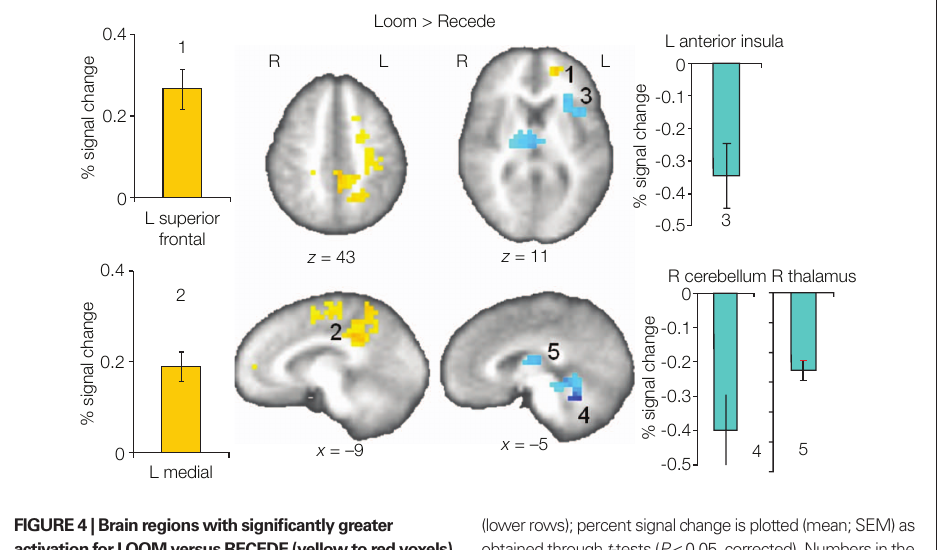
FIguRe 4 | Brain regions with significantly greater activation for LOOM versus ReCeDe (yellow to red voxels) and ReCeDe versus LOOM (blue voxels) contrasts. Activation is depicted in axial (upper row) and sagittal views